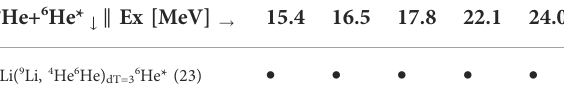
cannot be separated. Also, the datasets for which the relative TABLE 2 12 Be excited states observed in the 6 He+ 6 He*(1.8 MeV) decay. (cid:129) , indication of a peak Observation of a clear peak is labeled with energy of the reaction product pair corresponding to the 12 Be is at with ◦ ,andpossiblepeakobscuredbythebackgroundorotherpeaks, very high excitation are not considered, for example, the 4 He + or affected by the detection ef fi ciency, with ×. Tentative states are in 6 He coincidences for dT = 0. The dataset labels indicate the parenthesis. reaction exit channel in the form t(p,1 2)3, the identi fi er of the pair of detector segments in which reaction products were detected (dT = 0,1,2,3), and a pair of the reaction products forming the 12 Be state. For each dataset and each observed 12 Be state, the level of con fi dence of the peak observation is indicated: clear peak, indication of the peak (one with a small number of counts), and possible peak (one seen in other datasets, but in this case, it is obscured by contributions from the background or other peaks or affected by the detection ef fi ciency). An empty position in the table means that the particular dataset does not cover the 12 Be excitation energy interval of the peak observed in other datasets. The peaks with clear observation in, at least, two datasets are considered as the 12 Be states. Other peaks in the tables, all of them satisfying aforementioned criteria for a candidate for the state, are considered as tentative states.